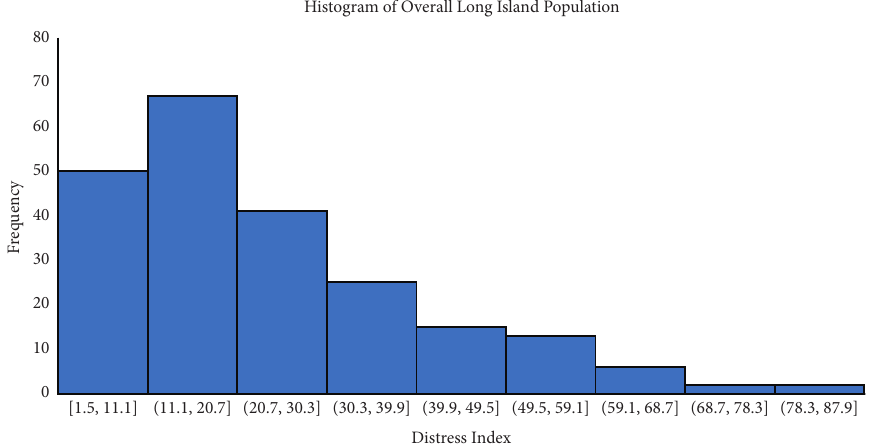
Figure 1: Histogram of the distressed communities index across Long Island, New York. Table 1: Baseline medical history.